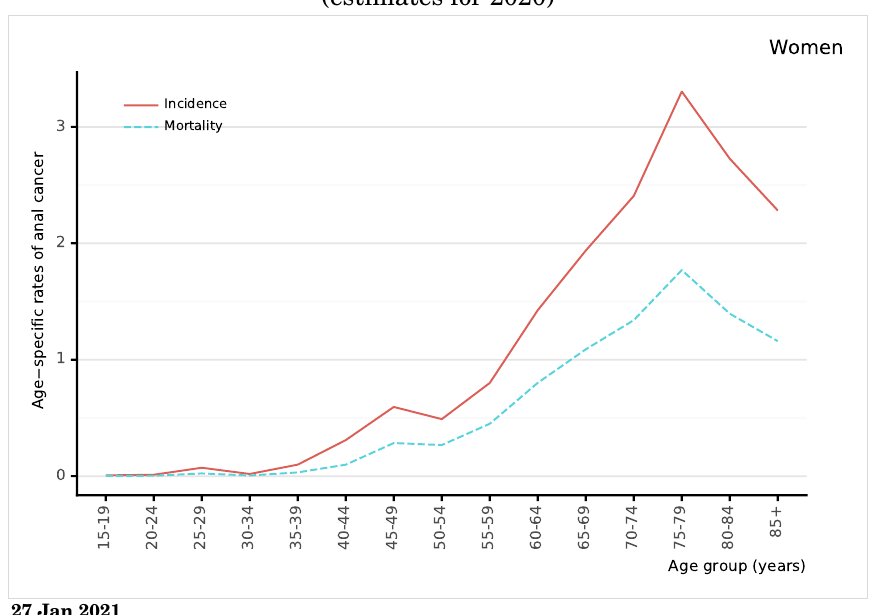
Figure 20: Comparison of age-specific anal cancer incidence and mortality rates among women in